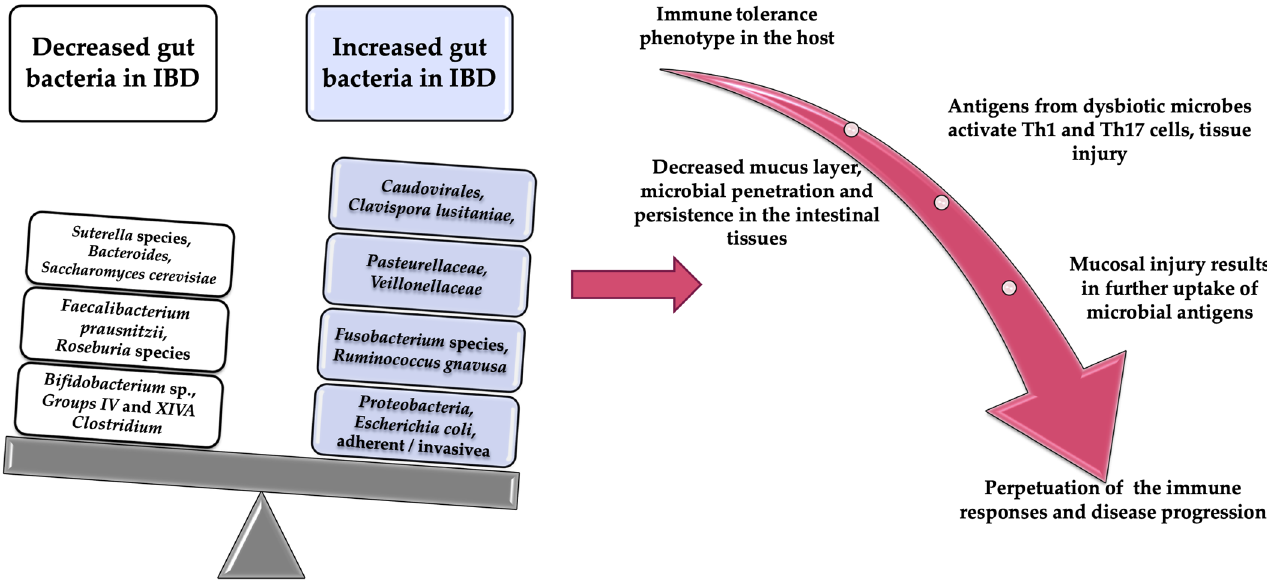
Figure 1. Altered gut bacteria implication in the pathogenesis of IBD.